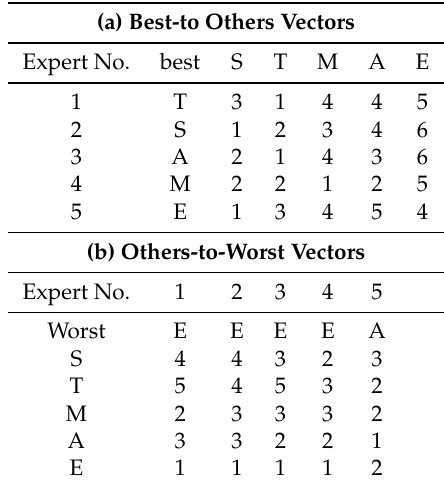
Table 1. The “best-to-others” and “worst-to-others” evaluation matrices. S: structural complexity; T: technical maturity; M: manufacturing stability; A: assembly stability; E: environmental conditions.